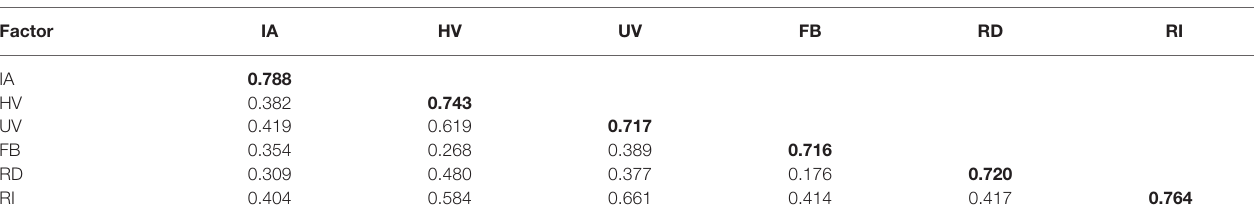
TABLE 4 | Results of discriminant validity